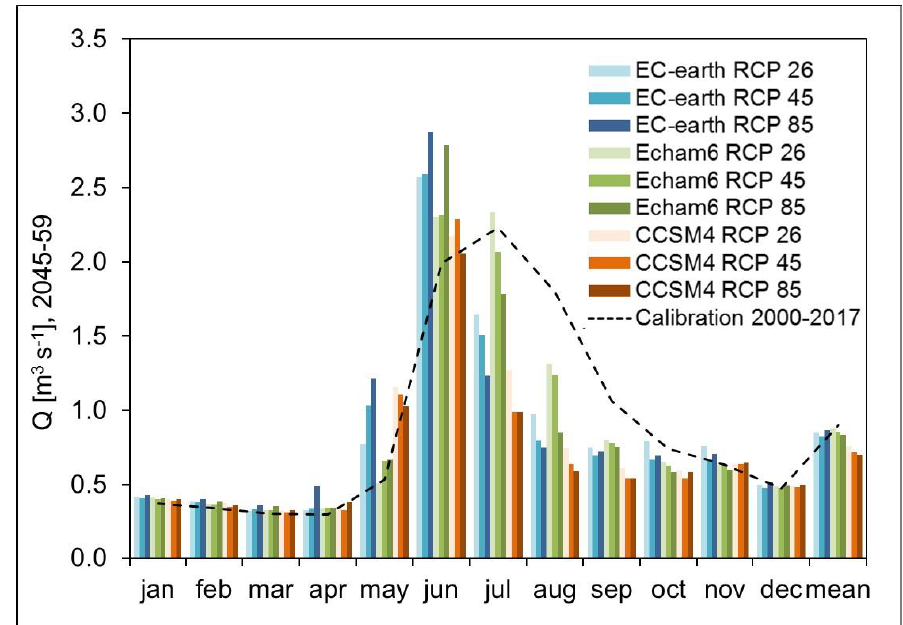
Figure 8. Sabbione catchment. Estimated mean monthly, and yearly mean discharge Q (m 3 s -1 ). Control Run (2005–2017) and projected for period P1 (2045–2059). Water 2019 , 11 , 1599